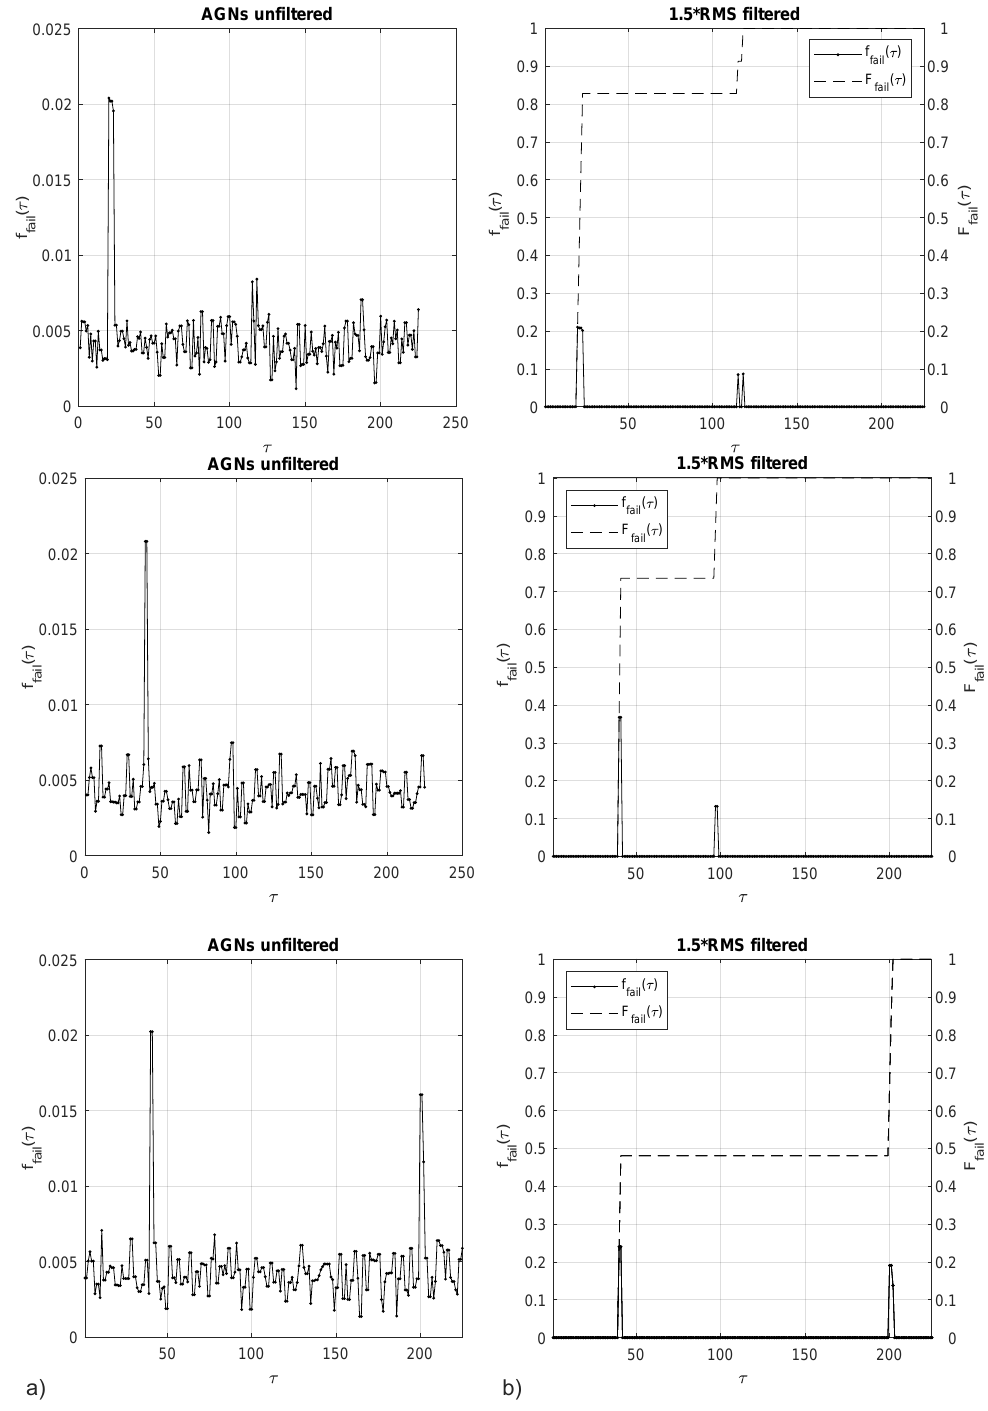
Figure 16. Probability density f fail ( τ ) of a loading profile from a GANs generated probability map RMS filtered f fail ( τ ) and accumulated probability F fail ( τ ) ( b ). Loading ( a ), probability density 1.5 × slopes from top to bottom are: (cid:101) 22 / (cid:101) 11 = 2.0, (cid:101) 22 / (cid:101) 11 = 3.7 and (cid:101) 22 / (cid:101) 11 =